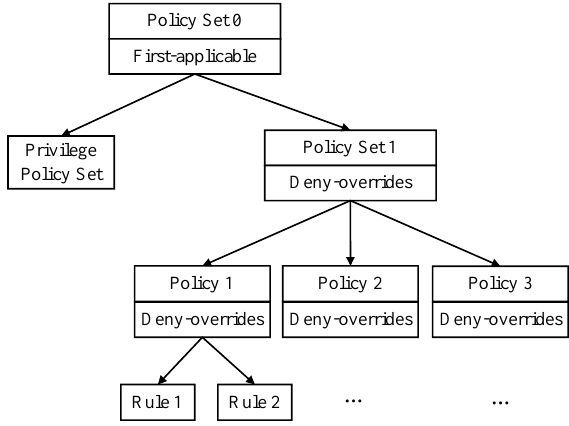
Figure 5. Specific use cases of the combination